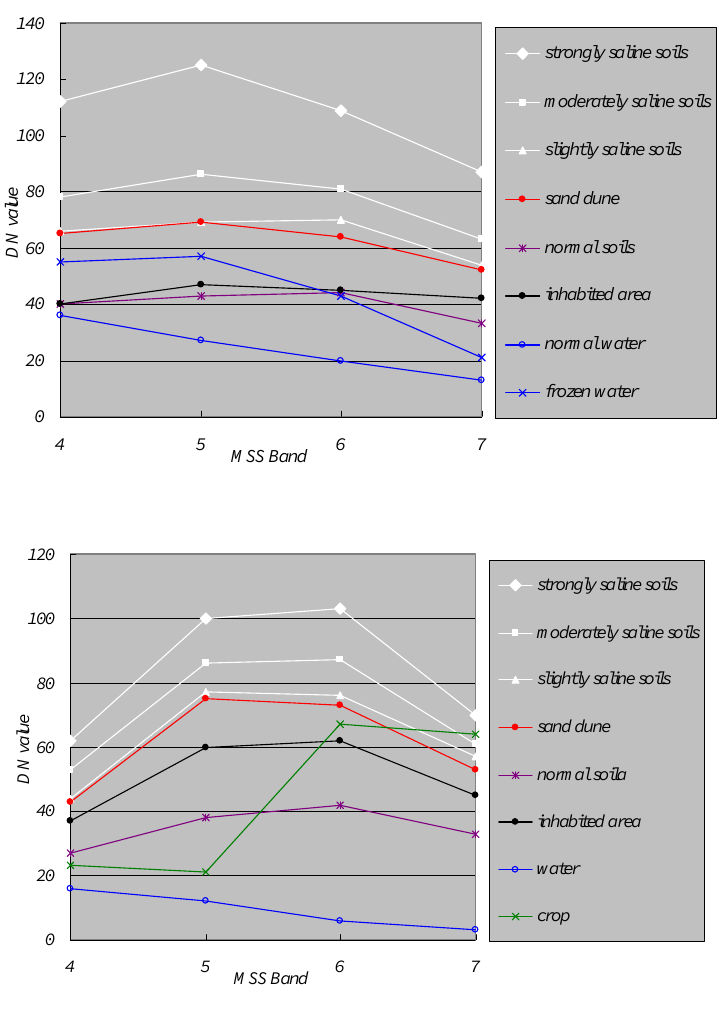
Figure 3. Typical spectral response in Landsat MSS (upper: 1973-03-20, lower: 1977-07-30).